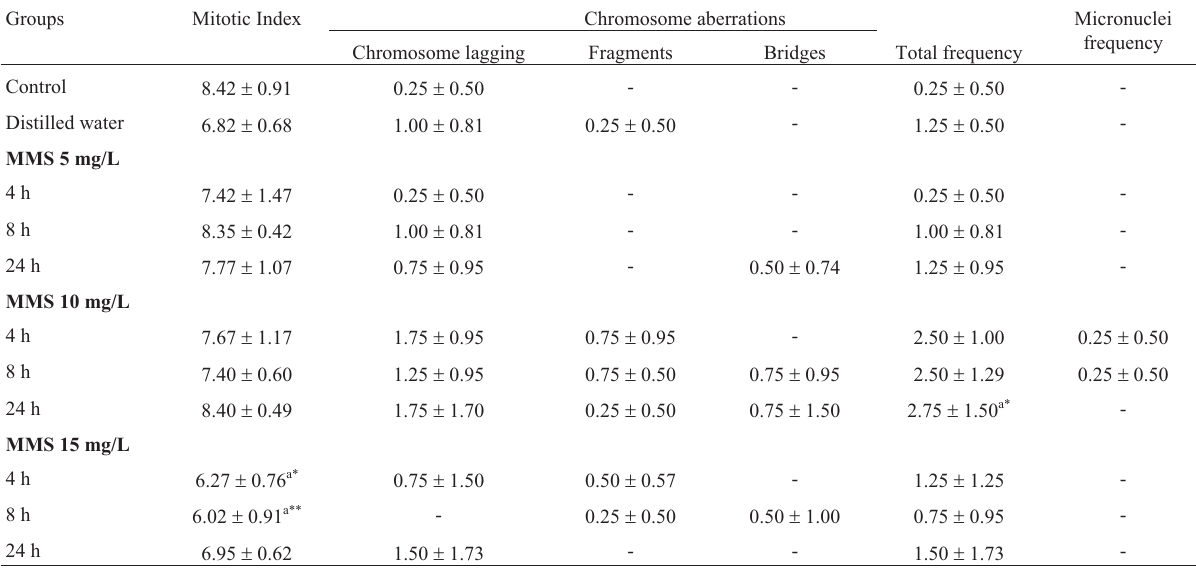
Table 1 - Mitotic index, frequency of chromosome aberrations and of micronuclei obtained in the cytogenetic tests on cells from the meristematic region (n = 4000) in roots of Oryza sativa L. accession BGA012099 “Ferrinho”, exposed to methyl methanesulfonate (MMS).